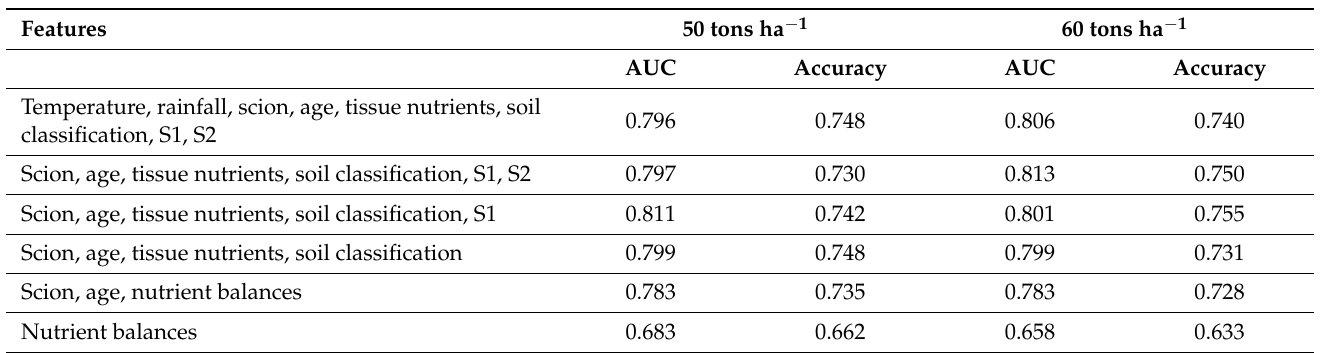
Table 5. Performance of the random forest binary classification model at yield cutoff values of 50 and 60 tons ha − 1 using cross-validation (10